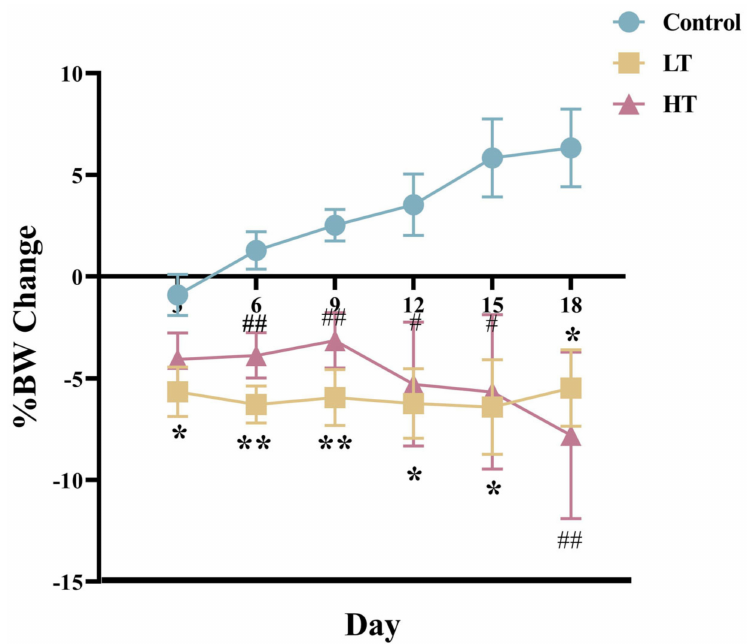
Figure 1. Body weight change during the 18-day TA intragastric administration to male Brandt’s voles. Control, 0 mg • kg − 1 d − 1 TA; LT, 600 mg • kg − 1 d − 1 TA; HT, 1200 mg • kg − 1 d − 1 TA; BW, body weight. %BW change = (Final BW − Initial BW)/Final BW × 100%. Data are presented as mean ± SEM, n = 8. * p < 0.05, ** p < 0.01 LT vs. control group; # p < 0.05, ## p < 0.01 HT vs. control group.